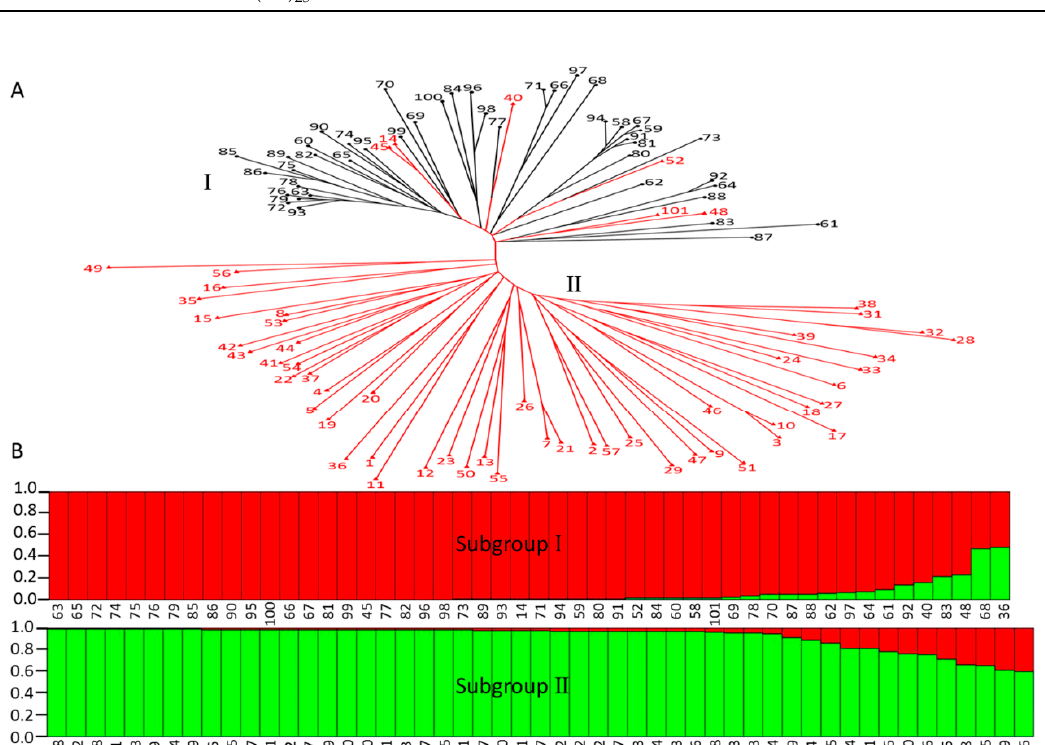
Figure 5. Genetic relationship among 101 apple accessions tested in this study based on 17 simple sequence repeats (SSRs). ( A ) A phylogenetic tree of apple cultivar and wild relatives constructed using SSR data; solid black spots and solid red triangles represent apple cultivars (black line) and wild relatives (red line), respectively. Apple accessions used for the construction of phylogenetic tree are listed in Table S1. ( B ) Bayesian clustering (STRUCTURE K = 2) of 101 apple accessions.